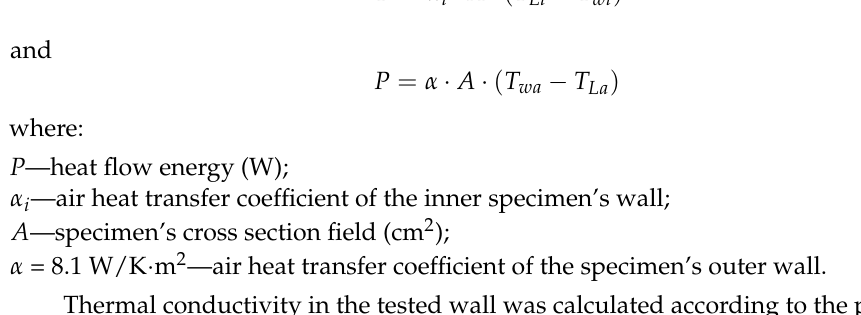
Figure 3. Scheme of heat transfer through the element.